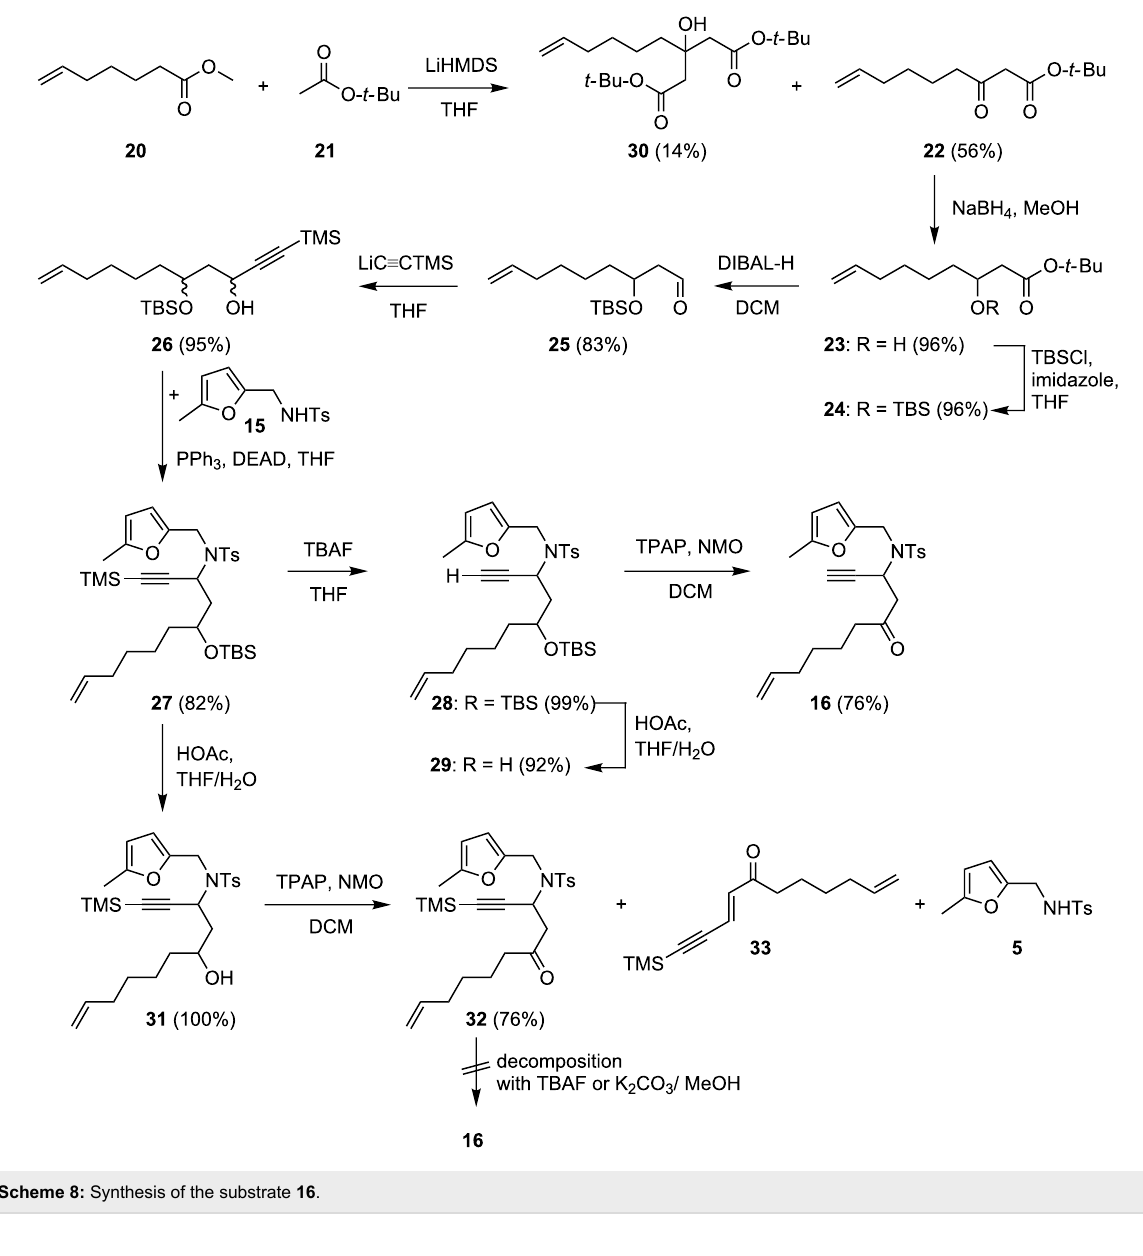
Scheme 8: Synthesis of the substrate 16 .